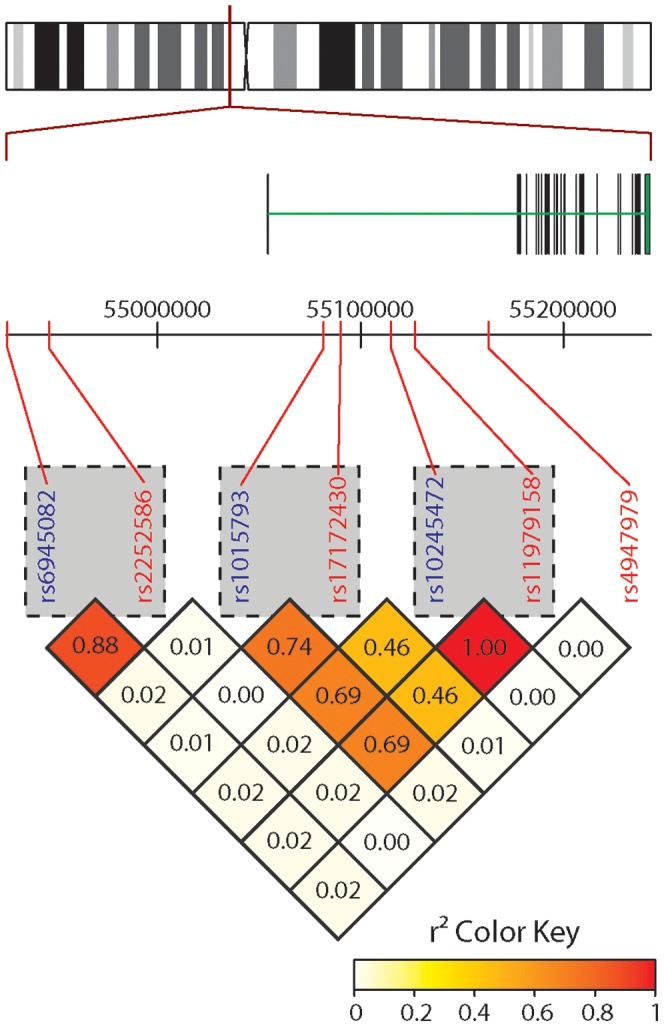
EGFR gene structure.Schematic diagram of the EGFR gene structure, marking all gene variants included in the study and their internal LD structure. Pairs of risk variants (red) and surrogate markers used in the UMU data (blue) are marked with dashed rectangles.